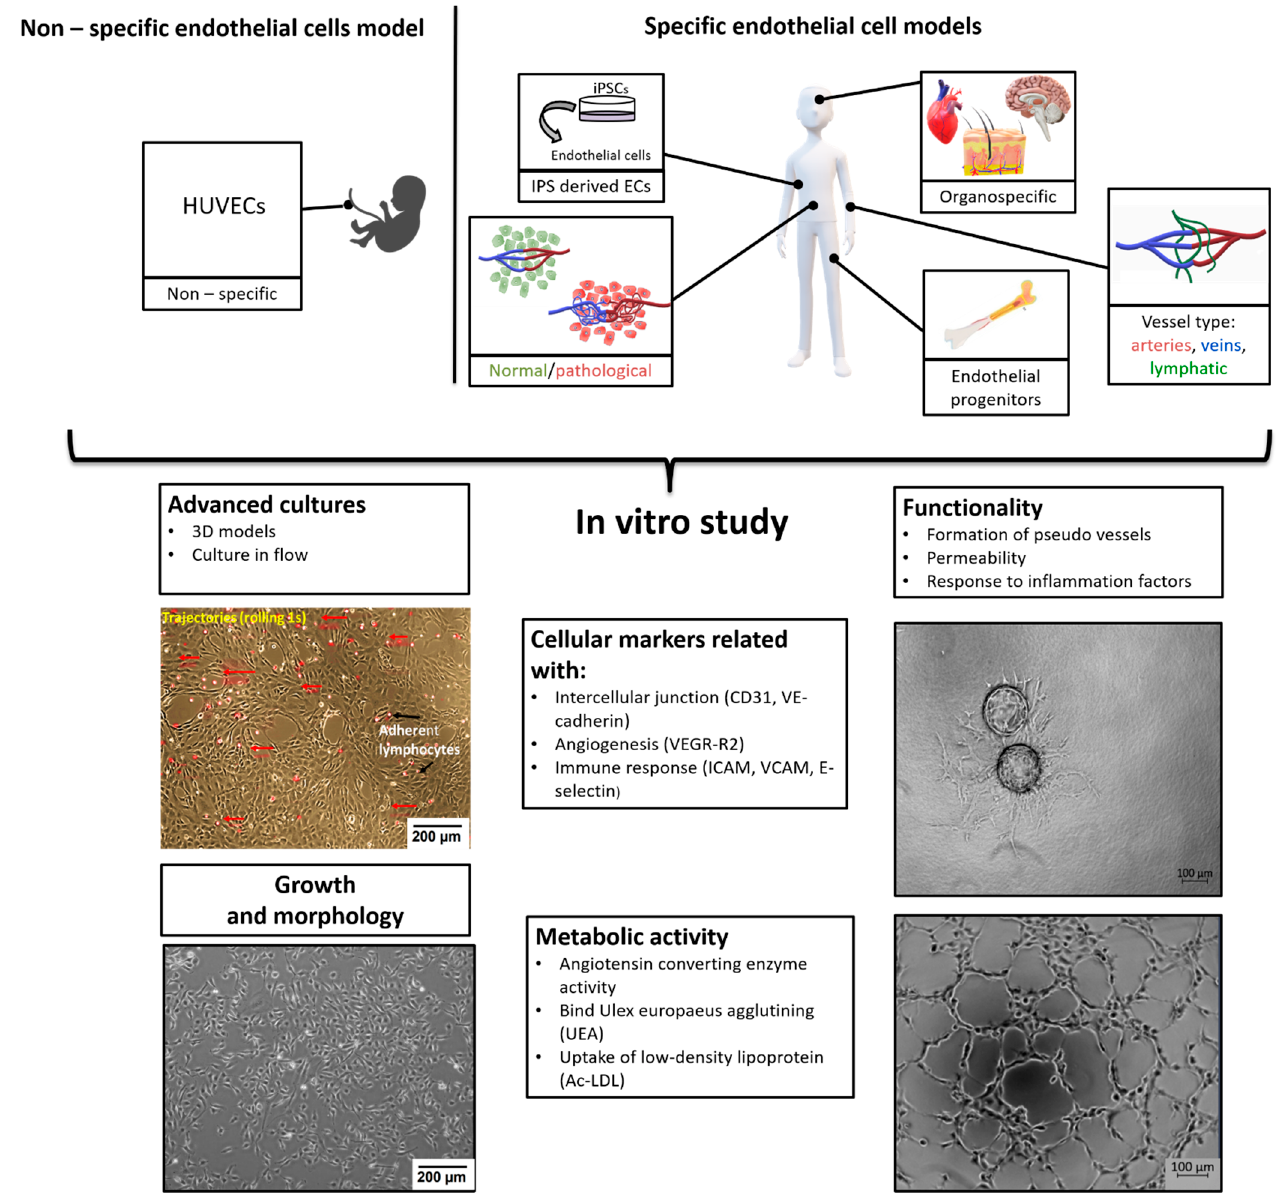
Figure 1. Organospecificity and plasticity of endothelial cells, selective angiogenesis model for signaling in pathologies and repair.